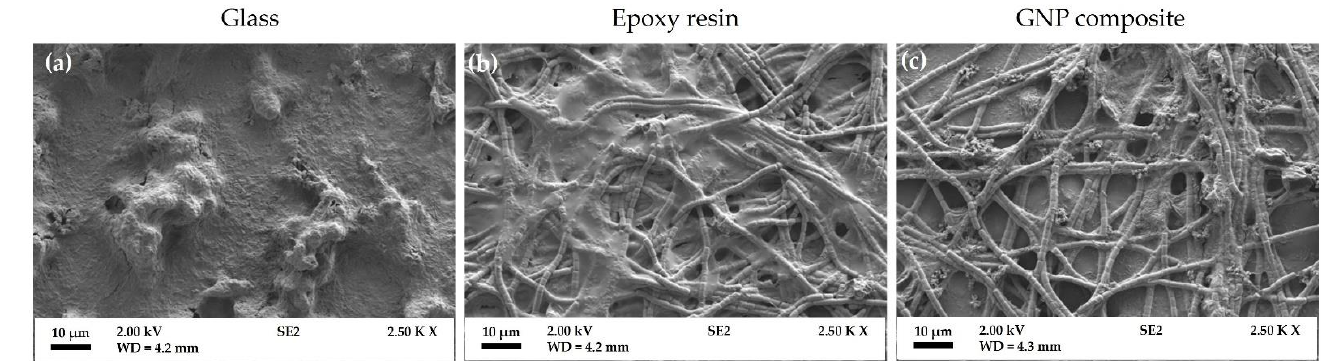
Figure 8. SEM micrographs of Lusitaniella coriacea LEGE 07157 biofilms grown on glass ( a ), epoxy resin ( b ), and GNP composite ( c ) after 49 days of incubation. Magnification = 2500×; scale bar = 10 µm.